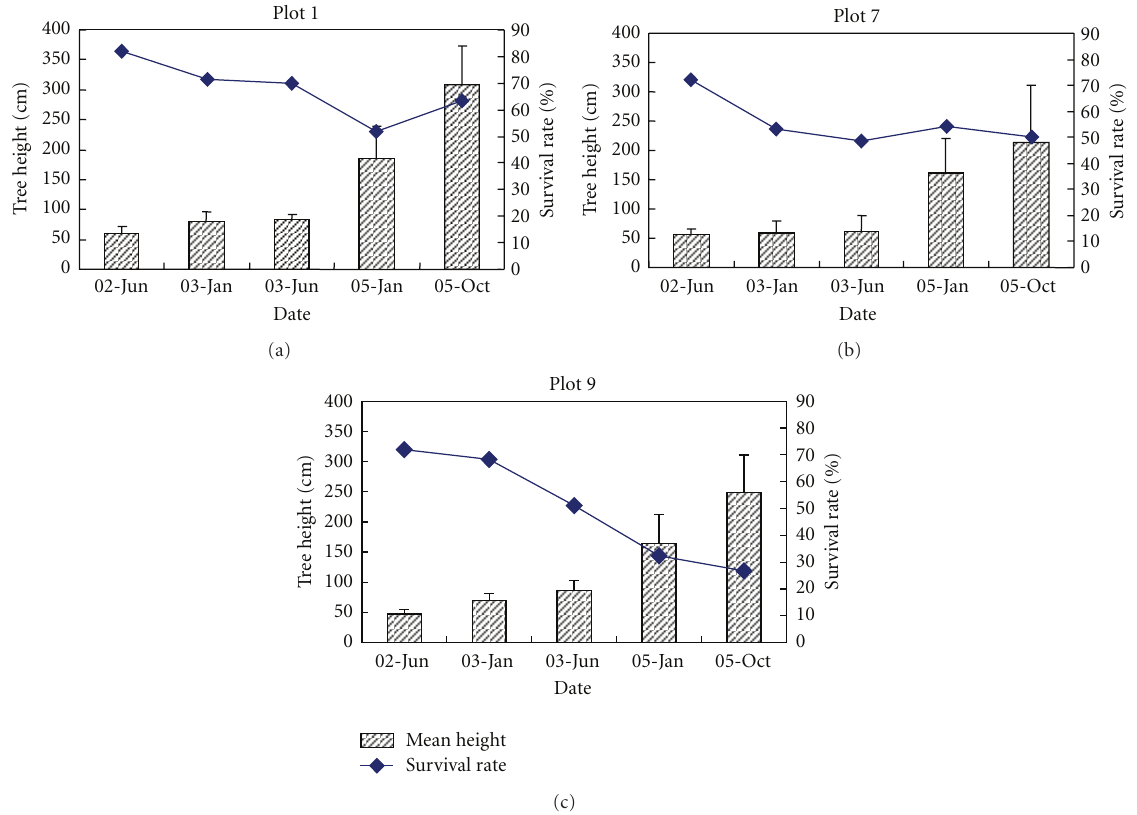
Figure 5: Survival and growth of planted mangroves measured in June 2002, January 2003, Jun 2003, January 2005, and October 2005. Locations of the plots are shown Figure 4. Error bars denote standard